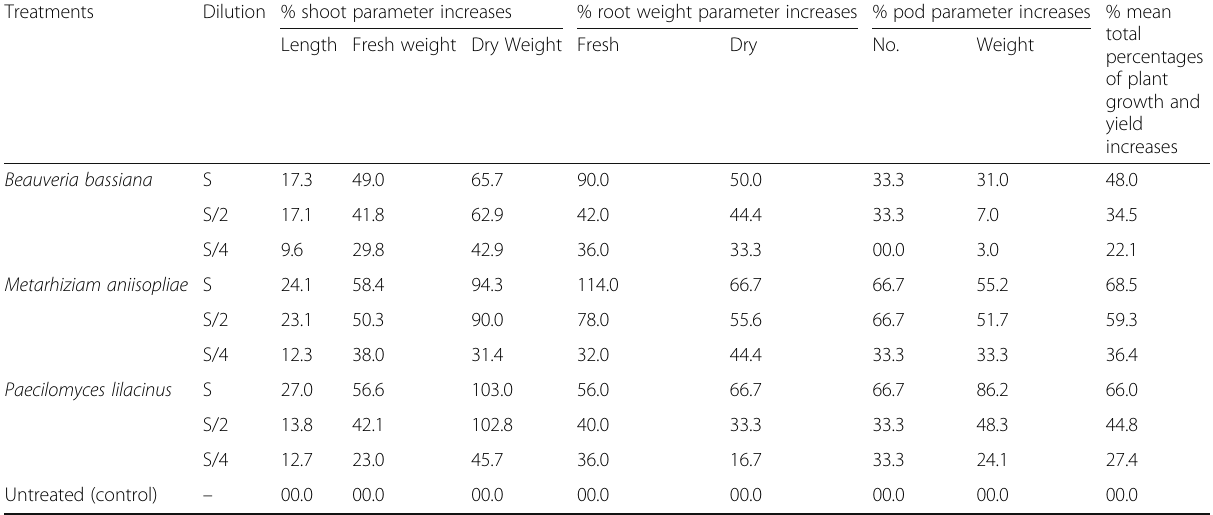
Table 9 Percentages of increase of vegetative parameters and yield of cowpea infected by root-knot nematode, Meloidogyne incognita , as affected by three fungal filtrates from Beauveria bassiana , Metarhiziam aniisopliae , and Paecilomyces lilacinus